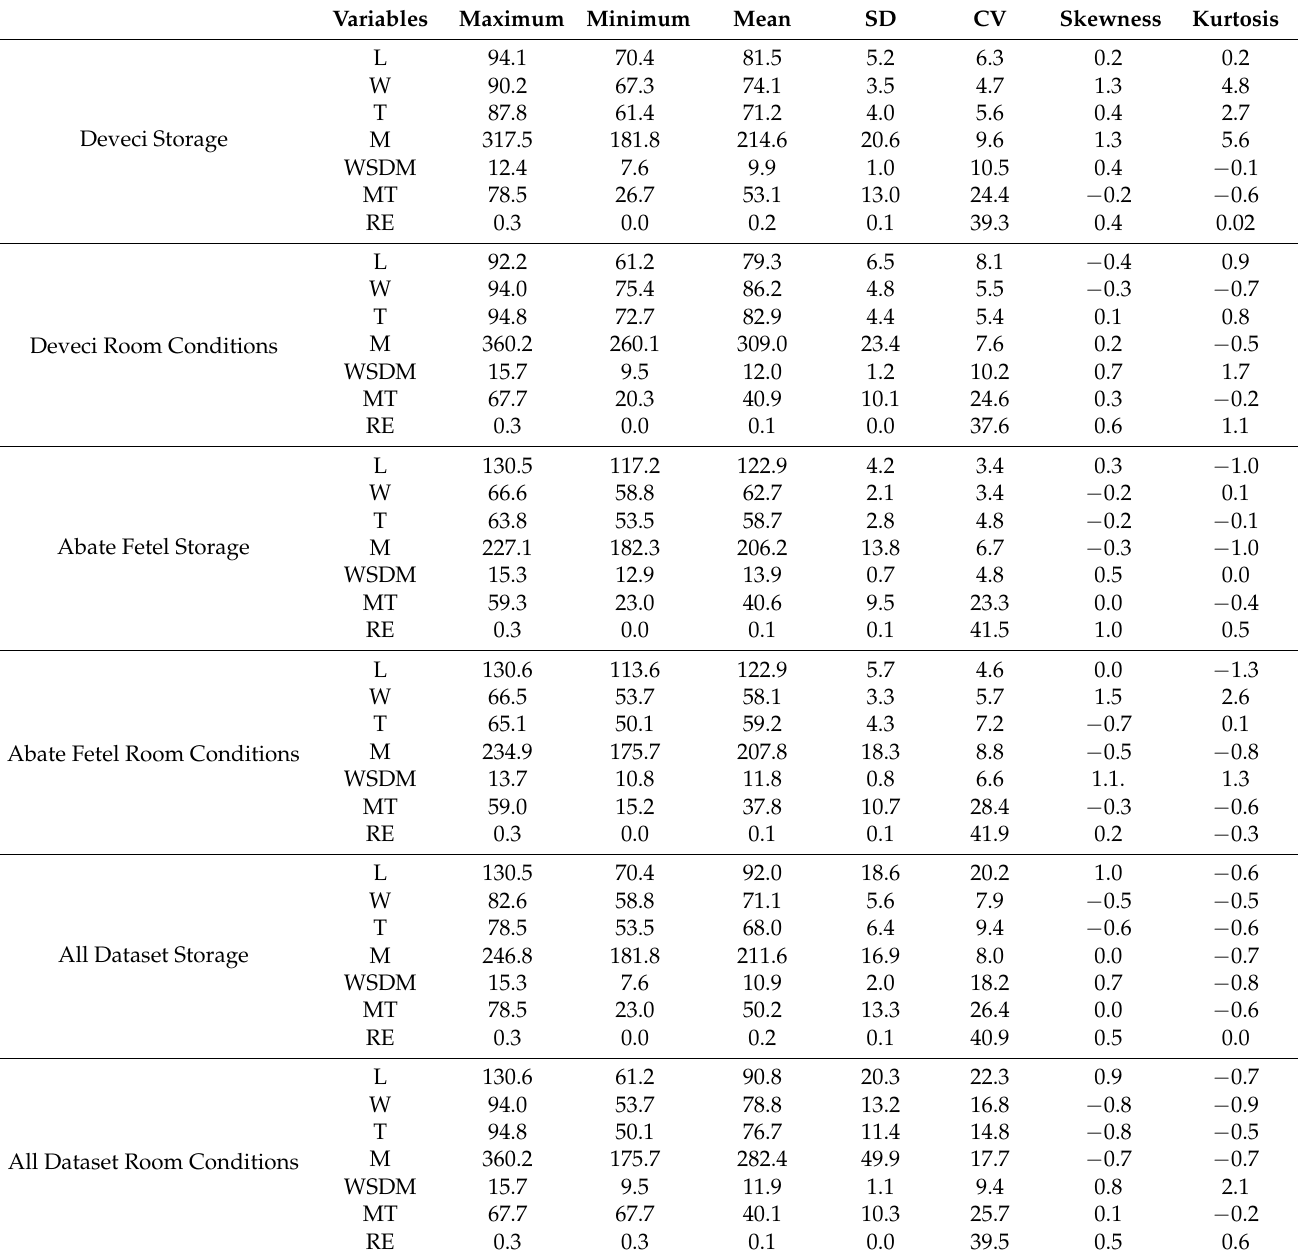
Table 2. Descriptive statistical parameters for Deveci and Abate Fetel fruits and all datasets in environmental conditions.